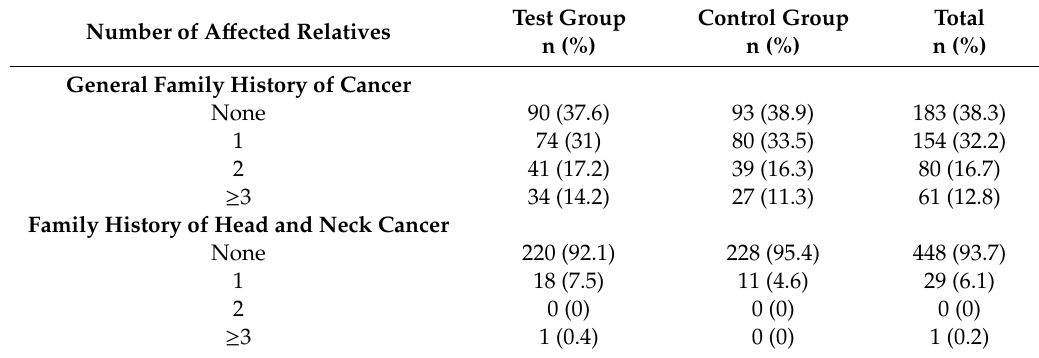
Table 6. Distribution of patients according to the number of a ff ected